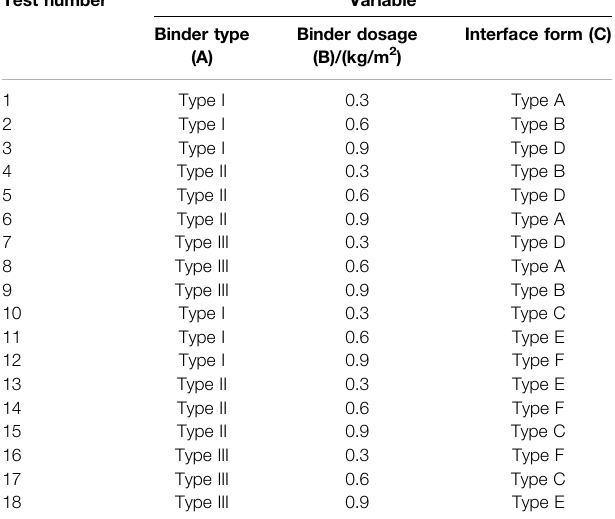
TABLE 5 | Orthogonal test